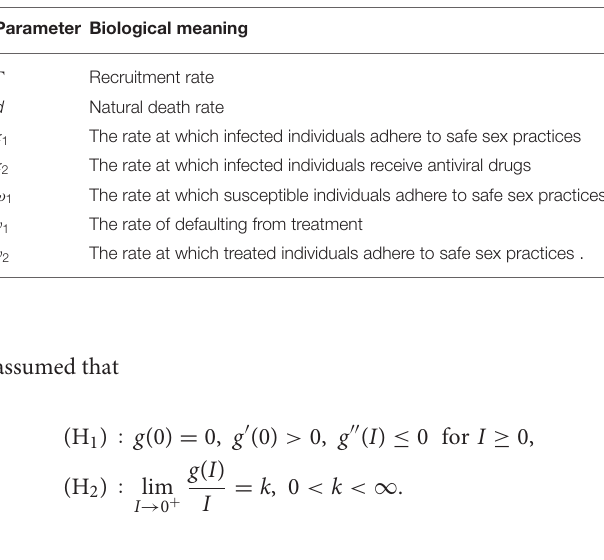
TABLE 1 | Biological meaning of